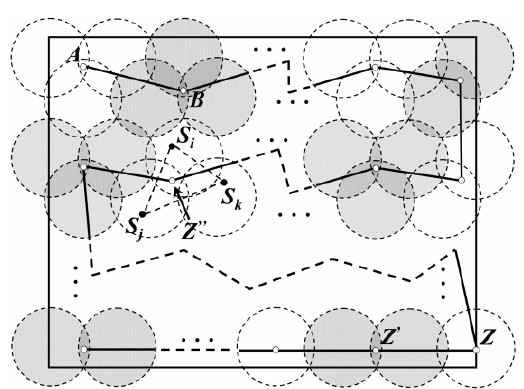
Figure 4. Trajectory of the mobile sink based on virtual regions [24].